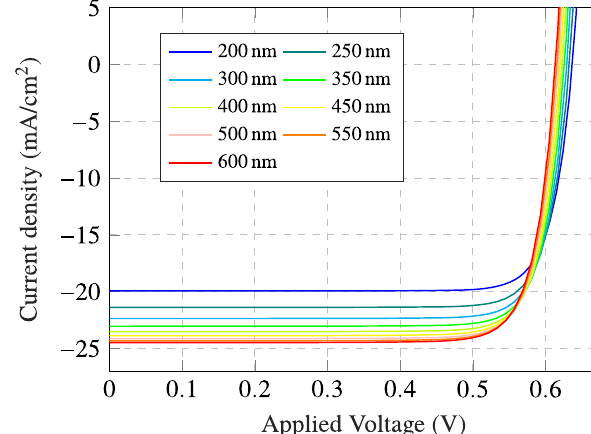
Fig. 4. Simulated J – V curves for the bottom cells fi ltered with a 350 nm thick, 1.55 eV bandgap of top cell. The bottom cell bandgap is fi xed at 1.0eV.